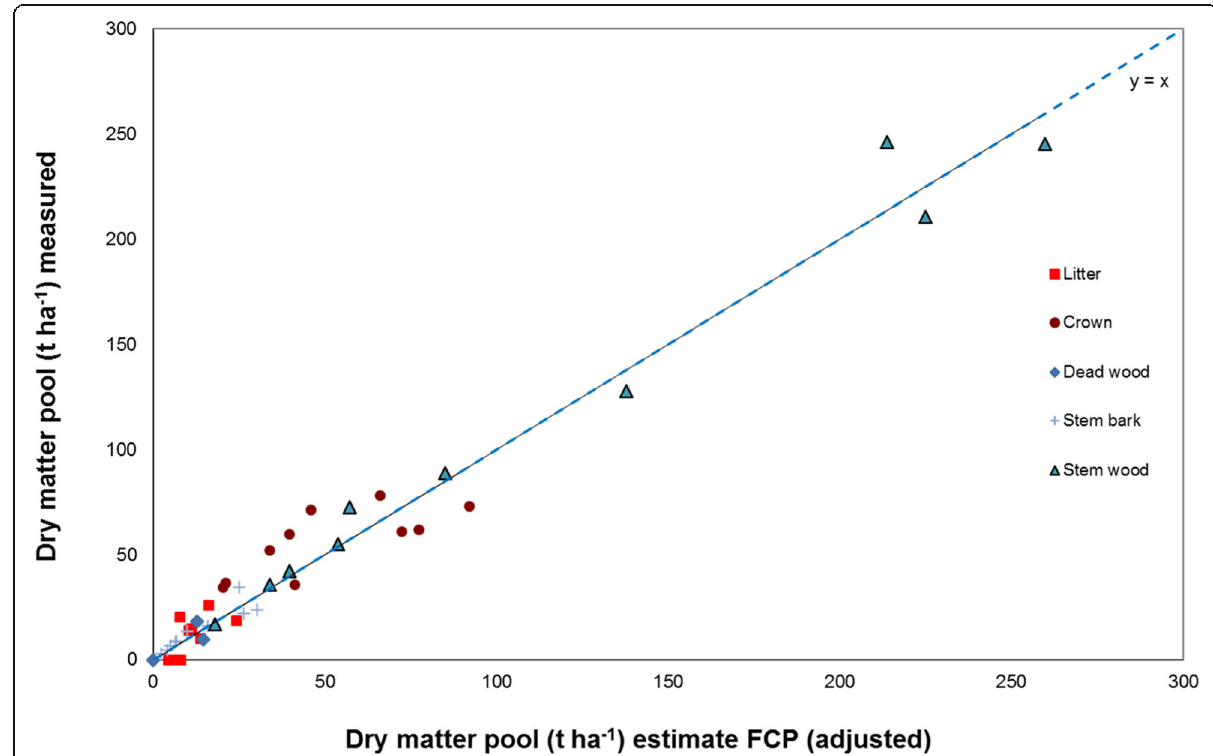
Fig. 2 Relationship between measured dry matter (DM) stocks in Douglas-fir stands and adjusted predictions using the Forest Carbon Predictor